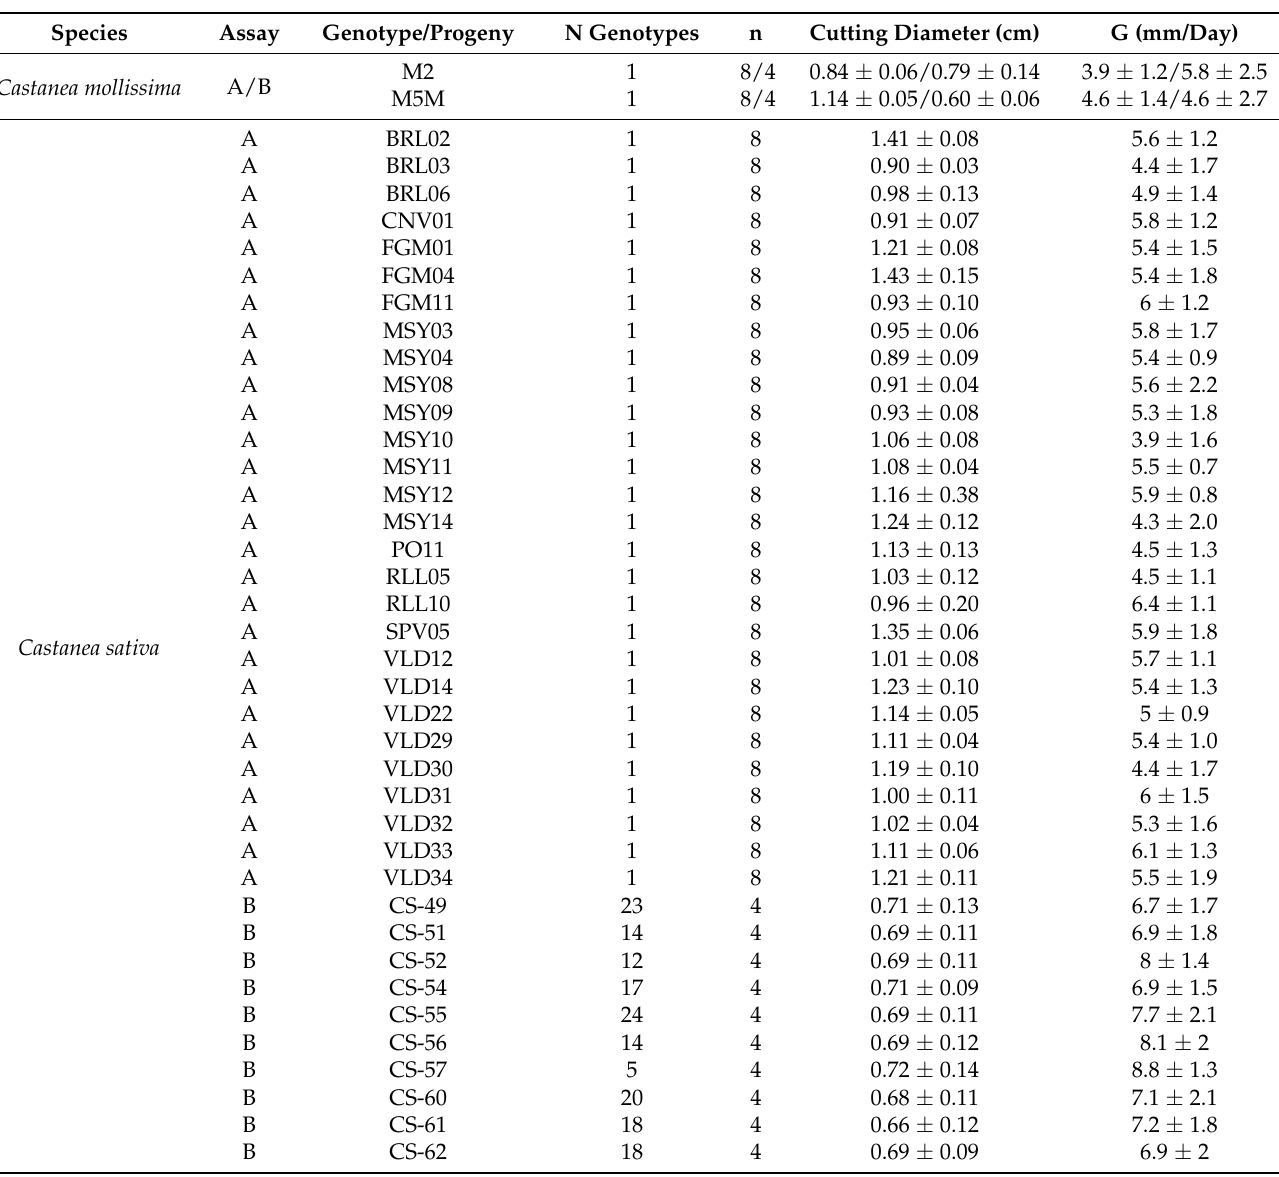
Table 1. Description of genotypes used in the in vitro assays (A and B). G: mean daily growth of the Cryphonectria parasitica colony from inoculation to the sixth day of incubation along the longitudinal axis. Data for genotypes of Castanea mollissima in assay A and B are shown in the left and right sides of the bar (/) respectively. n: number of replicates per genotype. Mean values and standard deviation are